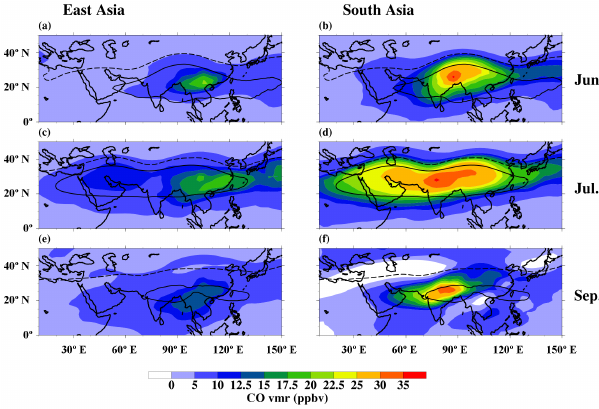
Figure 12. Same as in Fig. 11 for the distributions at